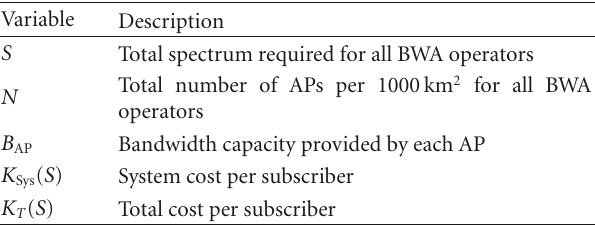
Table 1: Output variables.